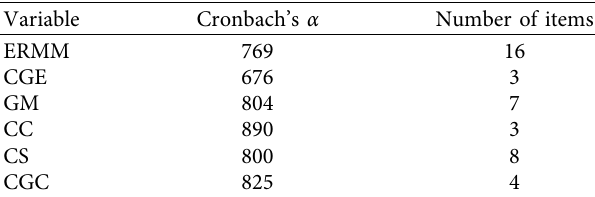
Table 2: Reliability test of enterprise risk management